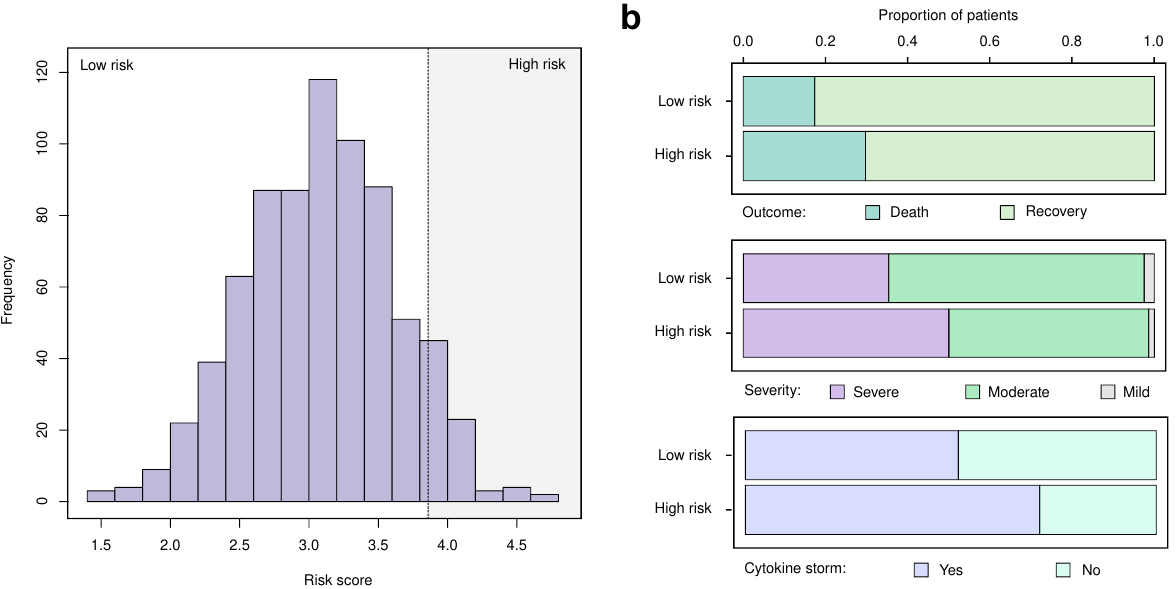
Figure 3. A risk score based on 11 identified variants predicts disease severity and outcome. ( a ) Distri- bution of the risk score computed based on the 11 lead SNPs shown in Table 1. Shaded area indicates the top score decile corresponding to high-risk individuals. ( b ) Bar plots showing the proportion of patients with different outcome (top), severity (middle), or presence of the cytokine storm (bottom) in the high-risk and low-risk groups. In all cases, p < 0.05 in chi-squared